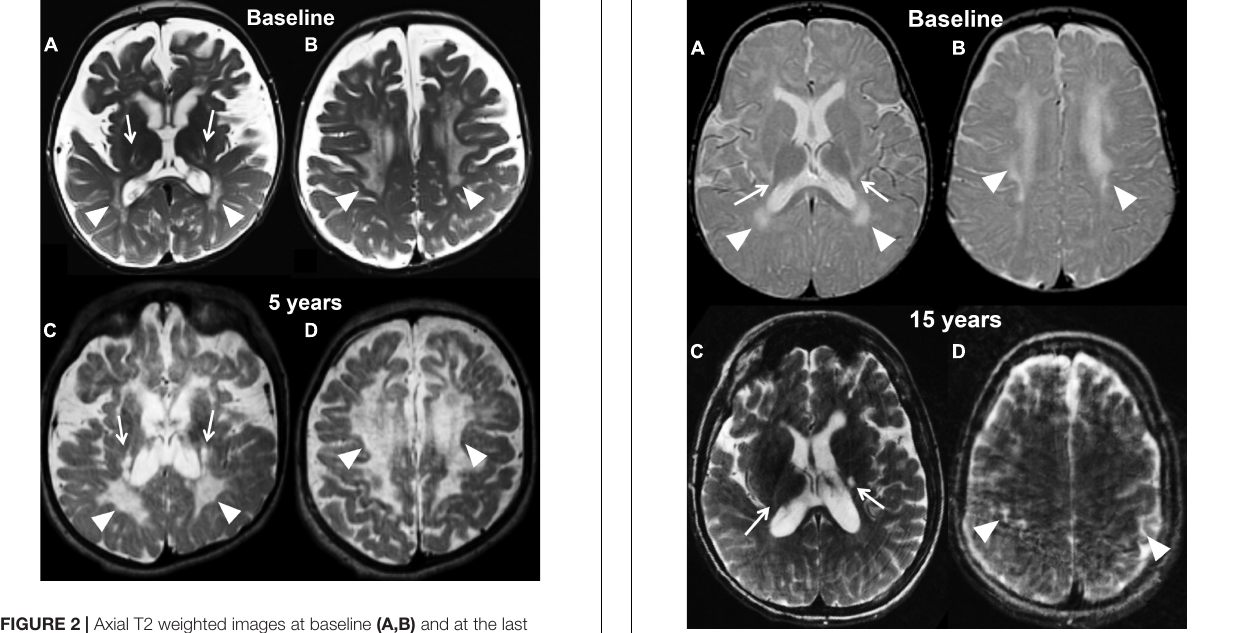
FIGURE 3 | Axial T2 weighted images of case 2 at baseline pre-transplantation (A,B) and at the last follow-up evaluation (C,D) . Panels (A,C) are planes crossing through the basal ganglia, while panels (B,D) are planes crossing through the corona radiata. The baseline study shows the typical changes associated with Krabbe disease at the level of the capsular regions (arrows, A ) and periventricular white matter and corona radiata ( A,B , arrowheads) in the setting of a still unmyelinated brain. The follow-up evaluation demonstrates a normally myelinated brain, with the exception for the posterior limbs of the internal capsules (arrows, A ). The white matter within the corona radiata is now normal appearing, with focal volume loss resulting in atrophy of the bilateral motor strip (arrowheads, D